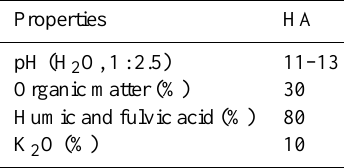
Figure 1. Effects of different rates of HA applications on soil mod- ulus of